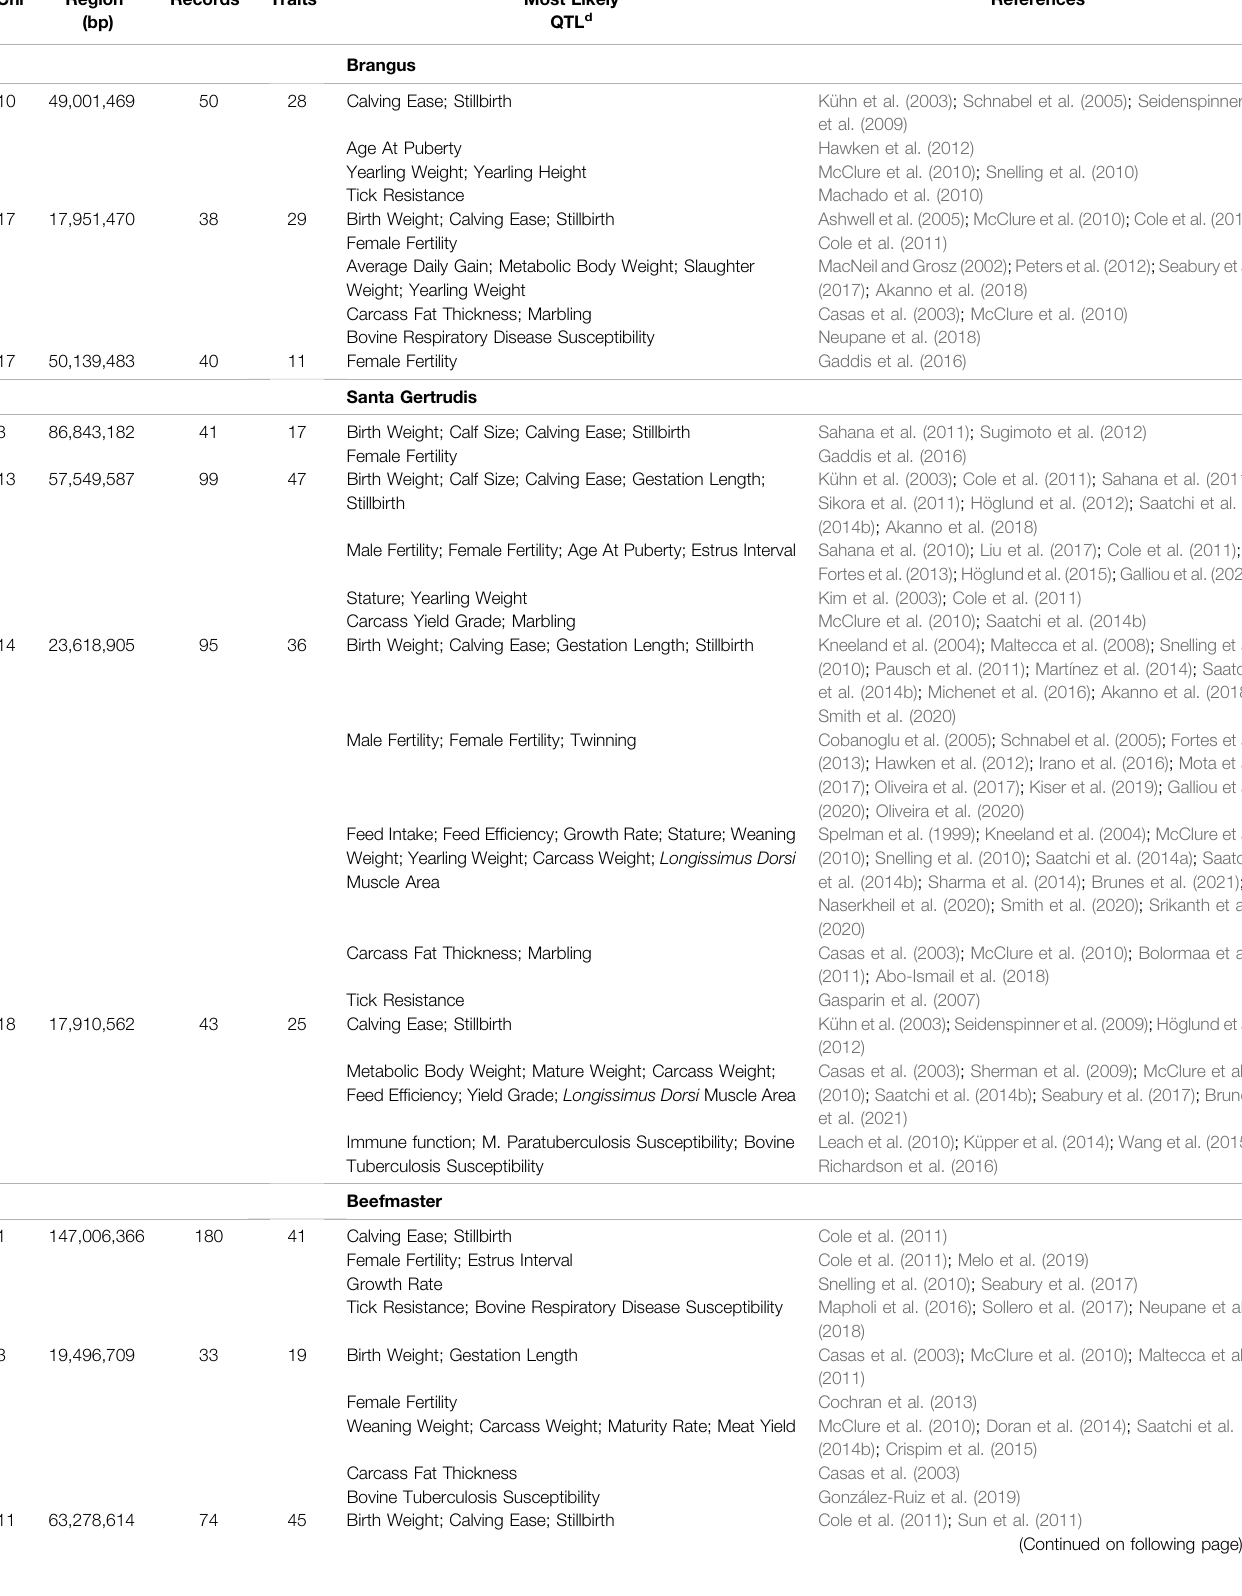
TABLE 5 | CattleQTLdb queries for QTL in fl uencing traits selected in U. S. beef cattle for regions enriched for taurine alleles in American Breed cattle. Chr Region a